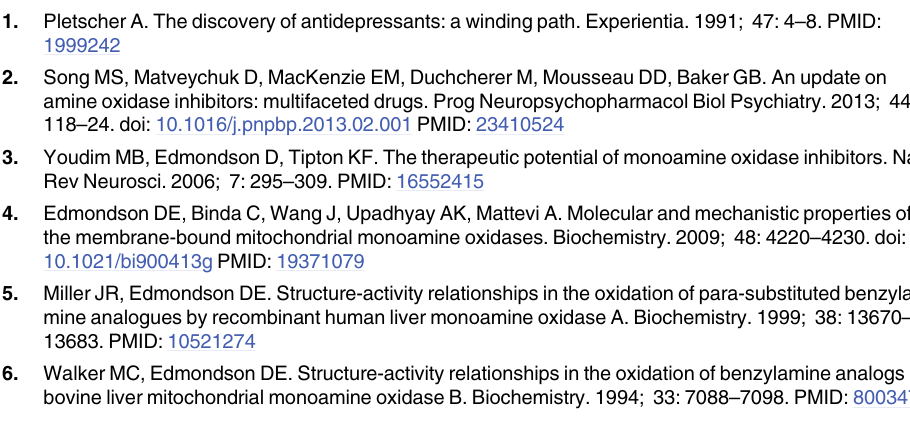
S4 Fig. Cluster considered for the transition state structure for p-MMP. Atoms and bonds are depicted as balls and sticks. p-MMP in yellow. All other atoms are depicted as follows: car- bon atoms in grey, oxygen atoms in red, nitrogen atoms in blue and hydrogen atoms in white. S5 Fig. Full NCI indexes of the transition state of p-CMP at the active site. NCI indexes col- oured ranging from 0.035 to -0.035 (au). For the sake of clarity some amino acid side-chains have been deleted from the figure. S6 Fig. Full NCI indexes of the transition state of p-MMP at the active site. NCI indexes iso- values coloured ranging from 0.035 to -0.035 (au). For the sake of clarity some amino acid side-chains have been deleted from the figure. S7 Fig. Proposed polar nucleophilic mechanism. This mechanism involves a proton transfer by means of a Nam-C4a adduct. S1 Table. Calculated contributions to free energy of activation for p-CMP and p-MMP complexed with